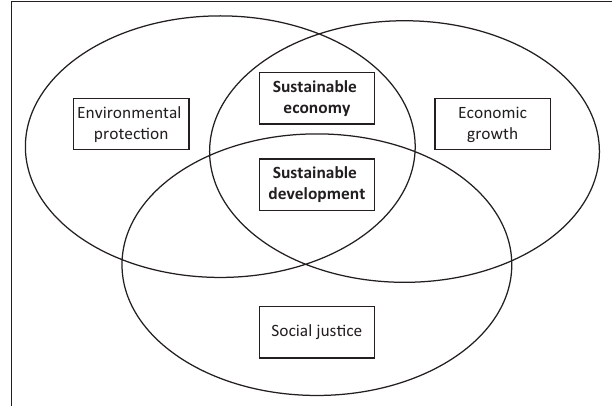
FIGURE 1: A visual representation of sustainable